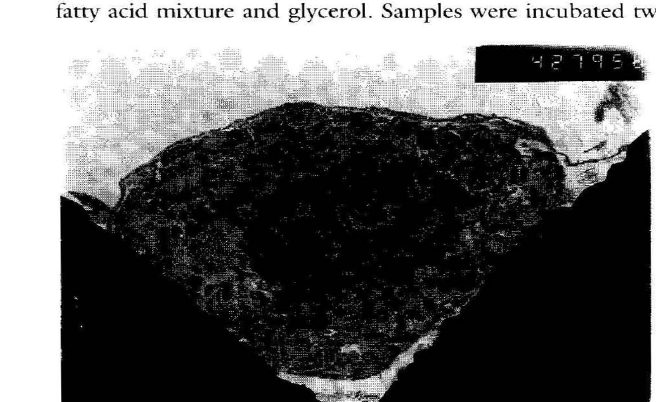
Figure 9. Concentrations (mean±S.D.) of cholesterol and phospholipids, as well as fatty acid content (in percent: mean ±S.D.) in controls (open bars) and in samples with 5 pmoljg wet weight isoxathopterin (dotted bars) and 30 pmol/ g wet weight isoxanthopterin (hatched bars). Samples of rat liver tissue homogenates were used to test tor phos pholipid biosynthesis in vitro. Incubation medium: Krebs-Ringer-phosphate bufter, containing 0.3% albumin (pH=7.4), fatty acid mixture and glycerol. Samples were incubated twice for 4 h at